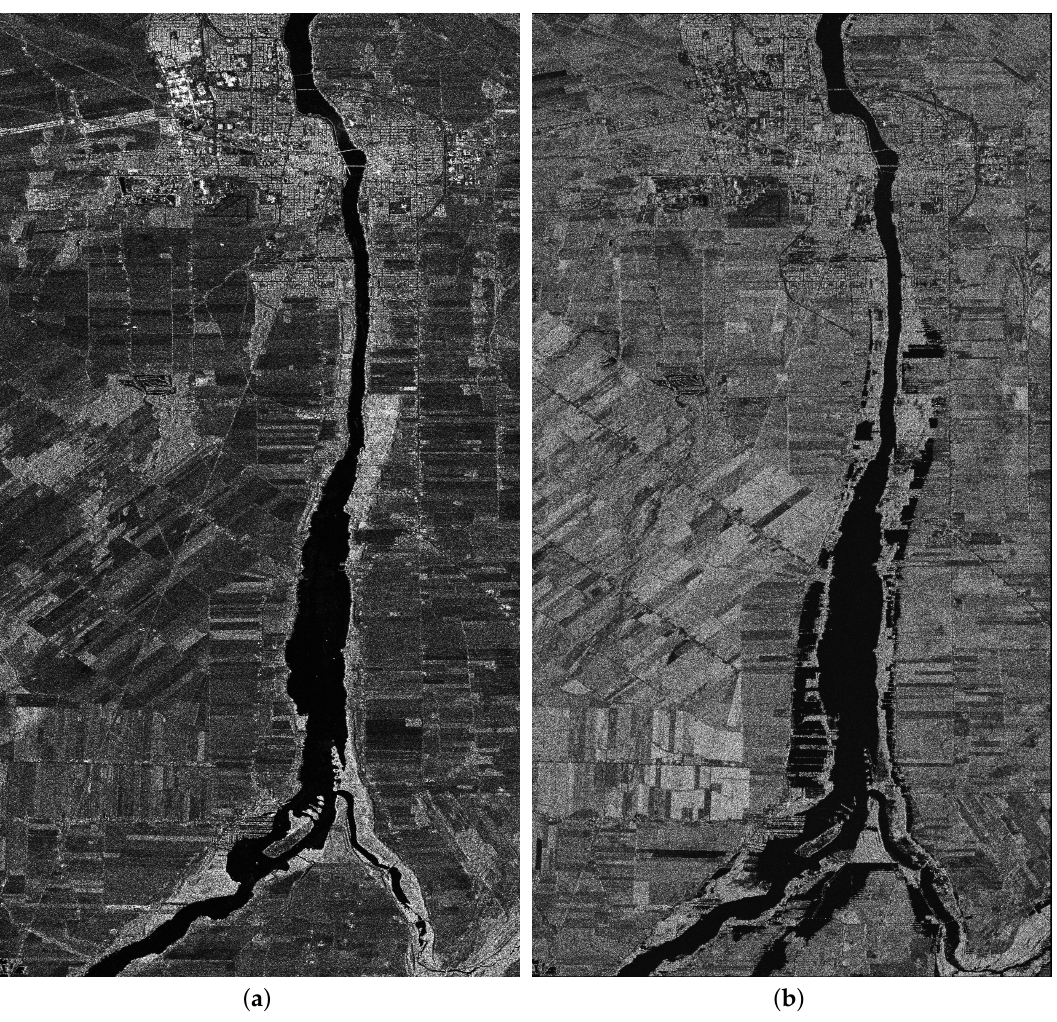
Figure 3. Pre- and post flooding SAR images (Approximate scale of the figure is 1:100,000 and the size of the area is 14 × 26 km 2 ). ( a ) Pre-flooding image (site 1); ( b ) Post-flooding image (site